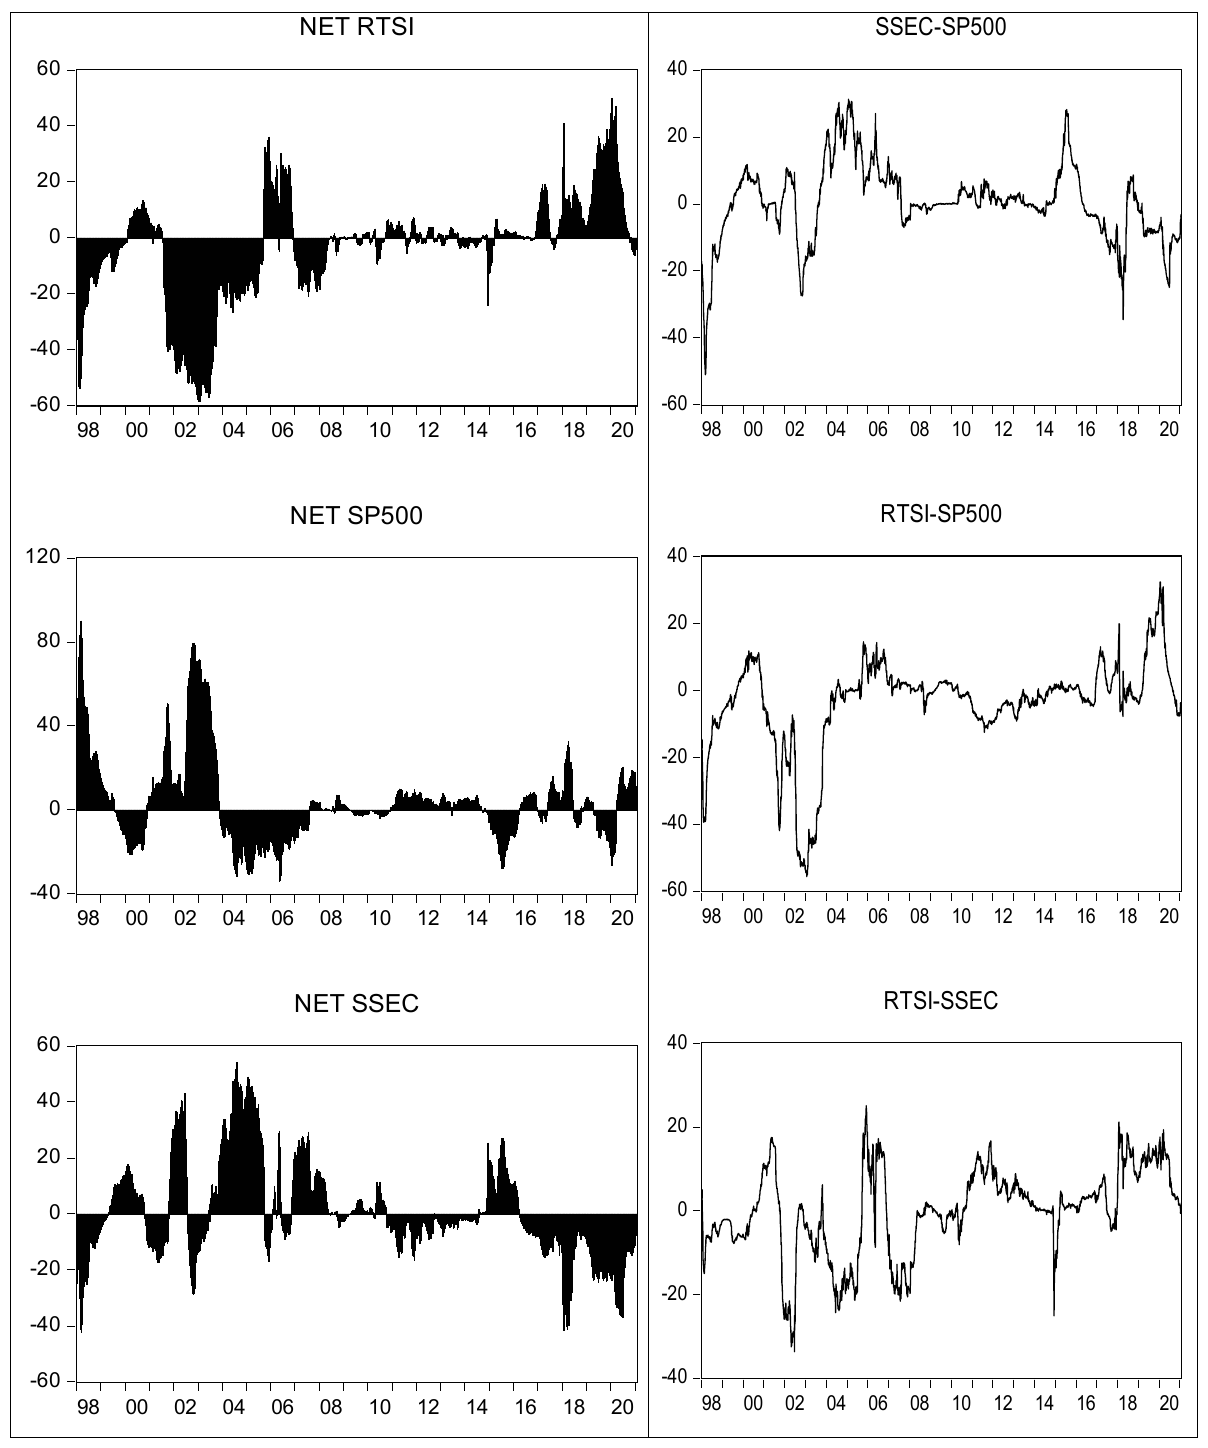
Figure 2. Net and pairwise volatility spillover. Figure 3 represents the dynamics of the total connectedness index. The degree of syn- chronization is the highest from 1998 to 2000. The magnitude of synchronization sharply declined in 2001 since a terrorist attack took place in that concurrent time, which motivates us to incorporate the role of geopolitical risk in our framework in the second stage of the analysis. The degree of synchronization is close to zero lines during the global financial crises. The rate of synchronization improved among the three markets in 2010–2012. TCI